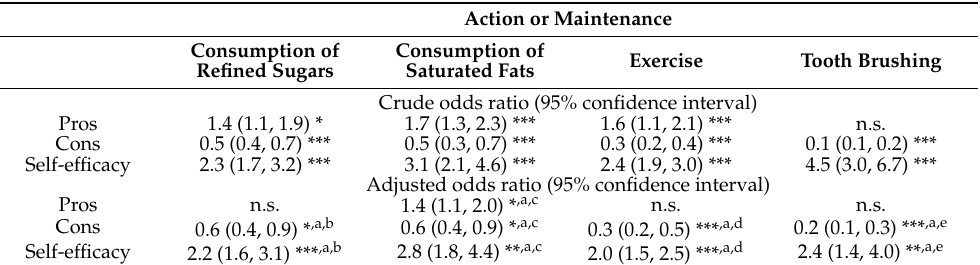
Table 3. Logistic regression analysis of cognitive factors and late stage of the behavior, patients with type 2 diabetes treated in primary care ( n =